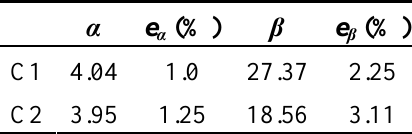
Table 2. Estimated model parameters and their errors.